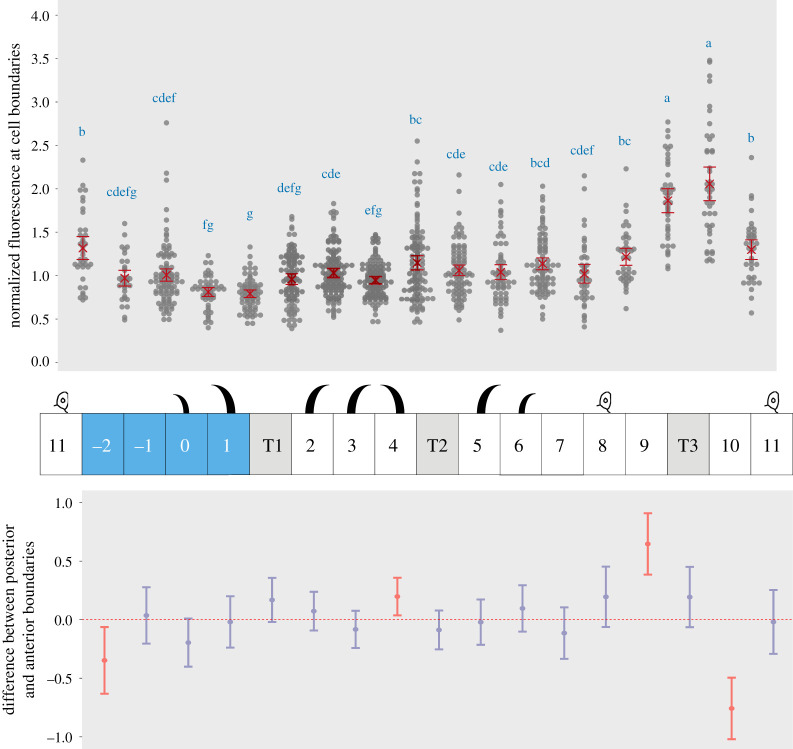
Quantitation of Ds levels at cellular interfaces across the segment. (Top) Dot plot of normalized fluorescence intensity maxima corresponding to amounts of Ds at boundaries between cell rows of the larval ventral abdomen. Data are pooled from 12 (denticulate area) and 5 (undenticulate area) images of different larvae. Mean value and 95% confidence interval for each interface are indicated in red. Letters arise from Tukey's multiple comparison test between all interfaces; in the Tukey's test, comparisons between pairs belonging to a group with the same letter show a p-value equal to or greater than 0.05. Groups can be assigned more than one letter, reflecting ‘overlap’ between different groups. The graph shows no evidence for a segment-wide gradient of Ds accumulation at the cell membranes, however the 9/T3 and T3/10 boundaries are significantly different from all others, indicating a clear peak anterior to the A/P boundary. (Middle) Diagram of denticle polarity, as in figure 1c. Sensory cells identify rows 8 and 11. (Bottom) Comparisons between Ds amounts at posterior and anterior interfaces of each cell row. Differences in mean normalized fluorescence at the opposite sides of a cell are calculated with 95% confidence interval by Tukey's test. Red indicates a significant difference. Note the significant and opposite differences in cell rows 9 and 10, highlighting the presence of a fluorescence peak around T3.